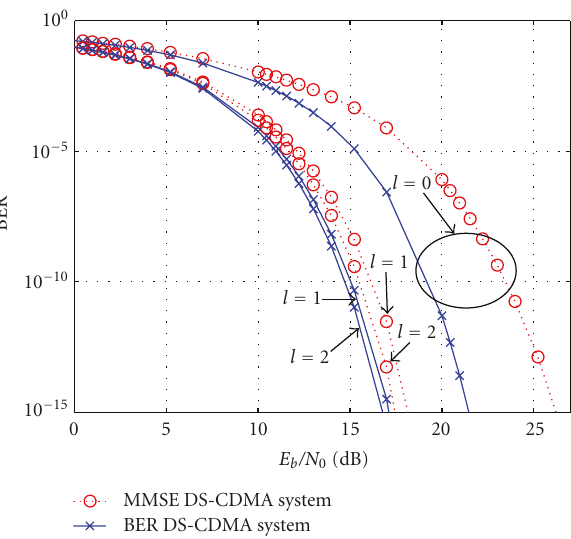
Figure 5: BER versus E b / N 0 performances of the MMSE DS- CDMA system ( ··· ◦ ··· ) and the proposed minimum BER DS- CDMA system ( −×− ) for di ff erent values of receiver filter memory l ∈ { 0,1,2 } , when M = 7, L = 5, and N = 3. When l increases, then the performance curves move